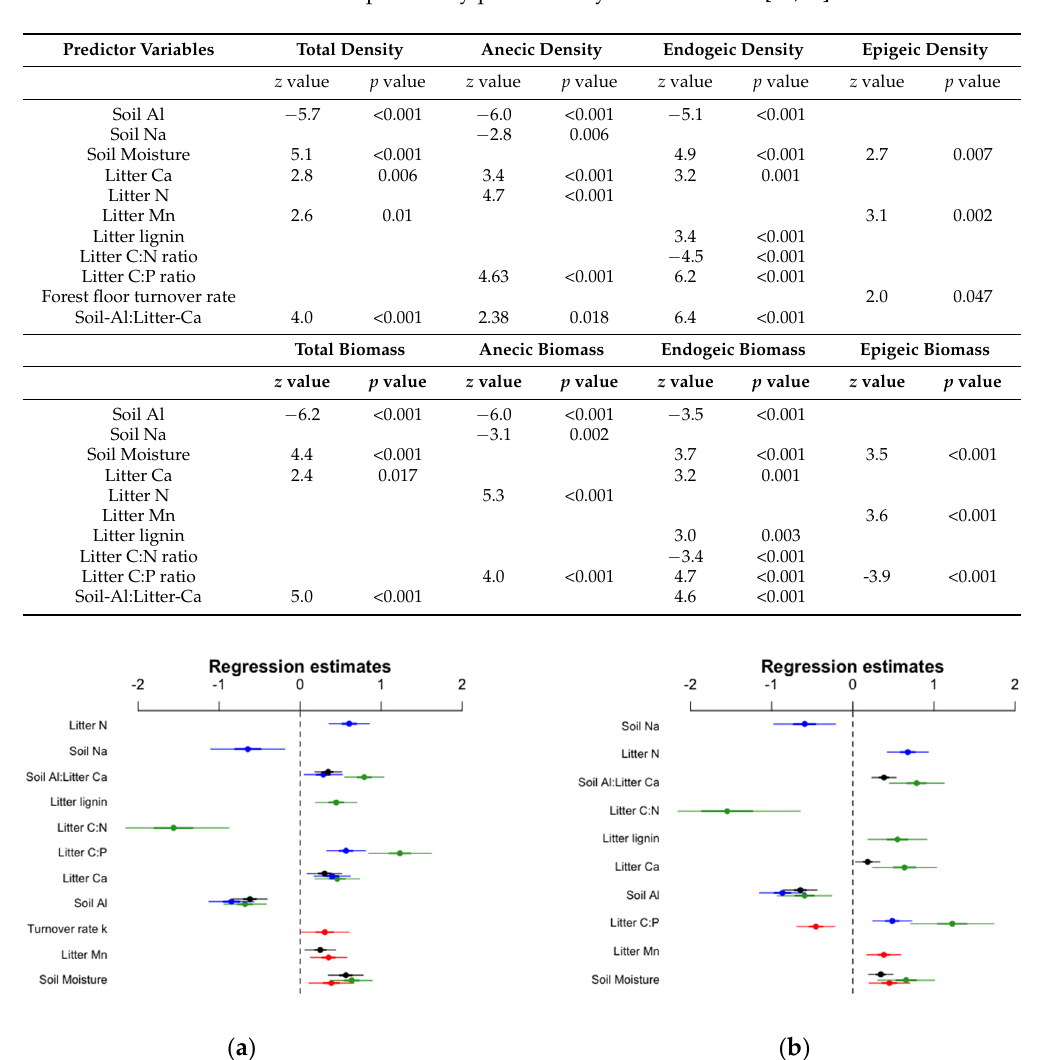
Figure 3. Estimated effects of litter and soil (0–5 cm) variables on the earthworm density ( a ) and biomass ( b ). Predictor variables were standardized to the mean and scales by the standard deviation, so that effects correspond to a change in the earthworm density/biomass (on the log ‐ scale) for a one standard deviation change in the predictor. This is true for all predictors, so their relative effects are comparable. The models are shown for total (black), anecic (blue), endogeic (green) and epigeic (red) earthworms. Coefficients are shown with confidence intervals by thick lines for 50% credible intervals and by thin lines for 95% credible intervals. We used glmmADMB zero inflated models with Site as group ‐ level effect. The foliar litter nutrient concentrations were previously published by Vesterdal et al. [35,36].